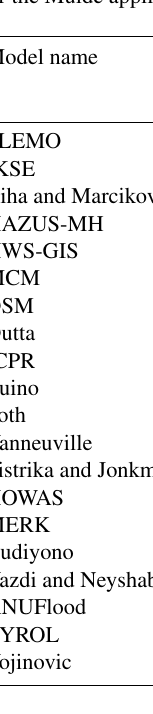
Table 5. Model scores for the Mulde application case.